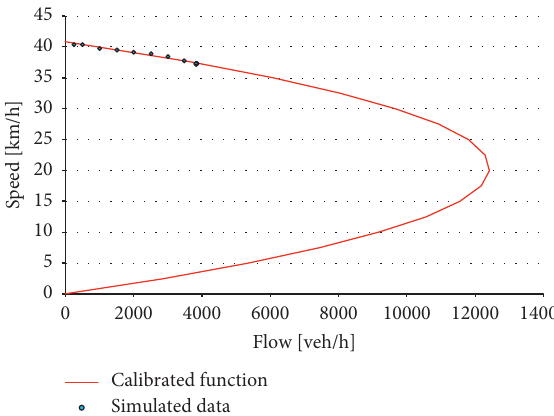
Figure 10: Calibrated function f � f ( v ) in the case of network configuration 3 for the interfaceable solution. Table 3: Global statistical tests related to function f � f ( v ) in the case of network configuration 1. R 2